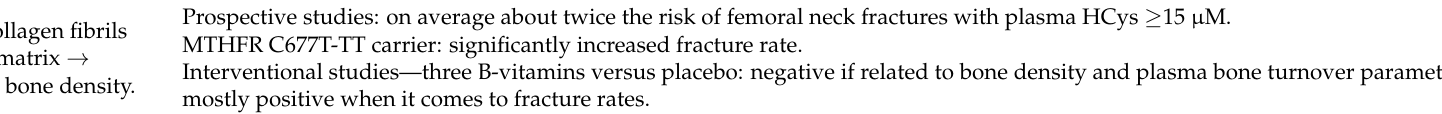
Table A11. Increased fracture rate in old age— Rev [75].